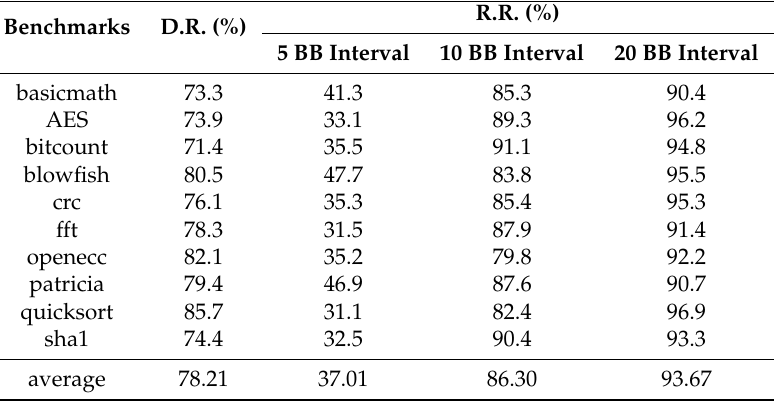
Table 5. Detection and recovery rating for buffer overflow on three stack